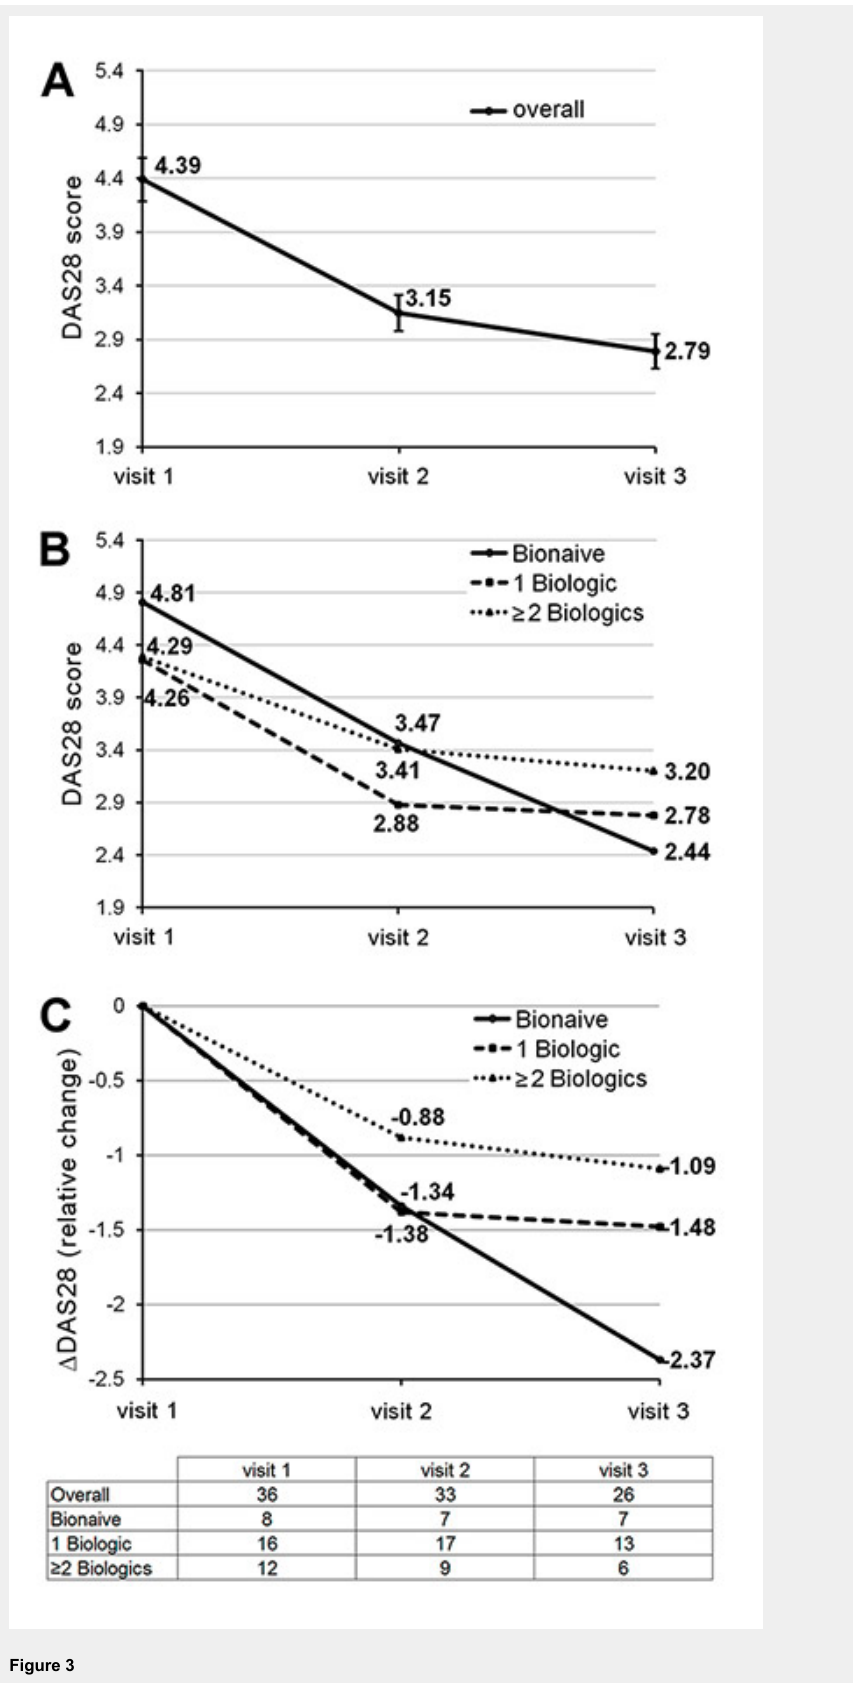
Figure 3 Change in DAS28 over time in the overall population and in the different subgroups. Data are mean values and, where indicated, with 95% confidence intervals. The table shows the numbers of patients with available DAS28-assessment at each visit. A) overall population; B) subgroup analysis showing absolute change in DAS28; C) subgroup analysis showing relative change in